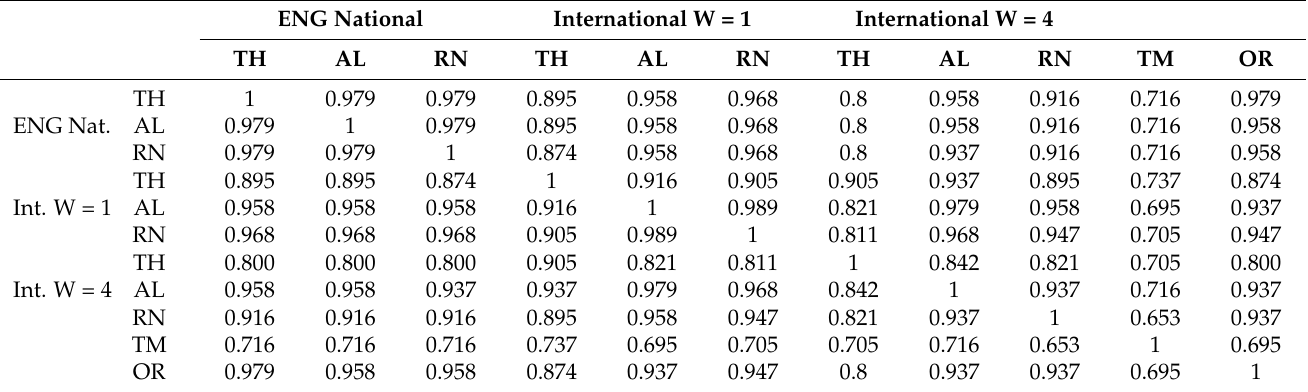
Table 6. Kendall’s tau rank correlations between the different rankings of English